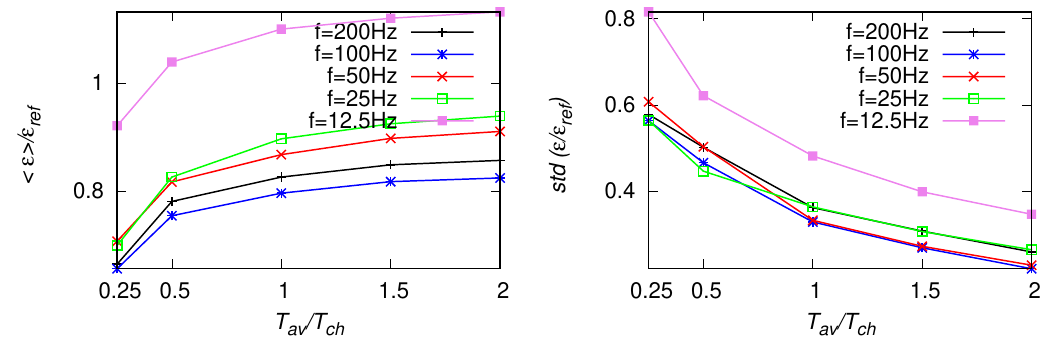
Figure 15. As in Figure 13, but for the fitting range f = [ 1 ÷ 5 ] Hz.